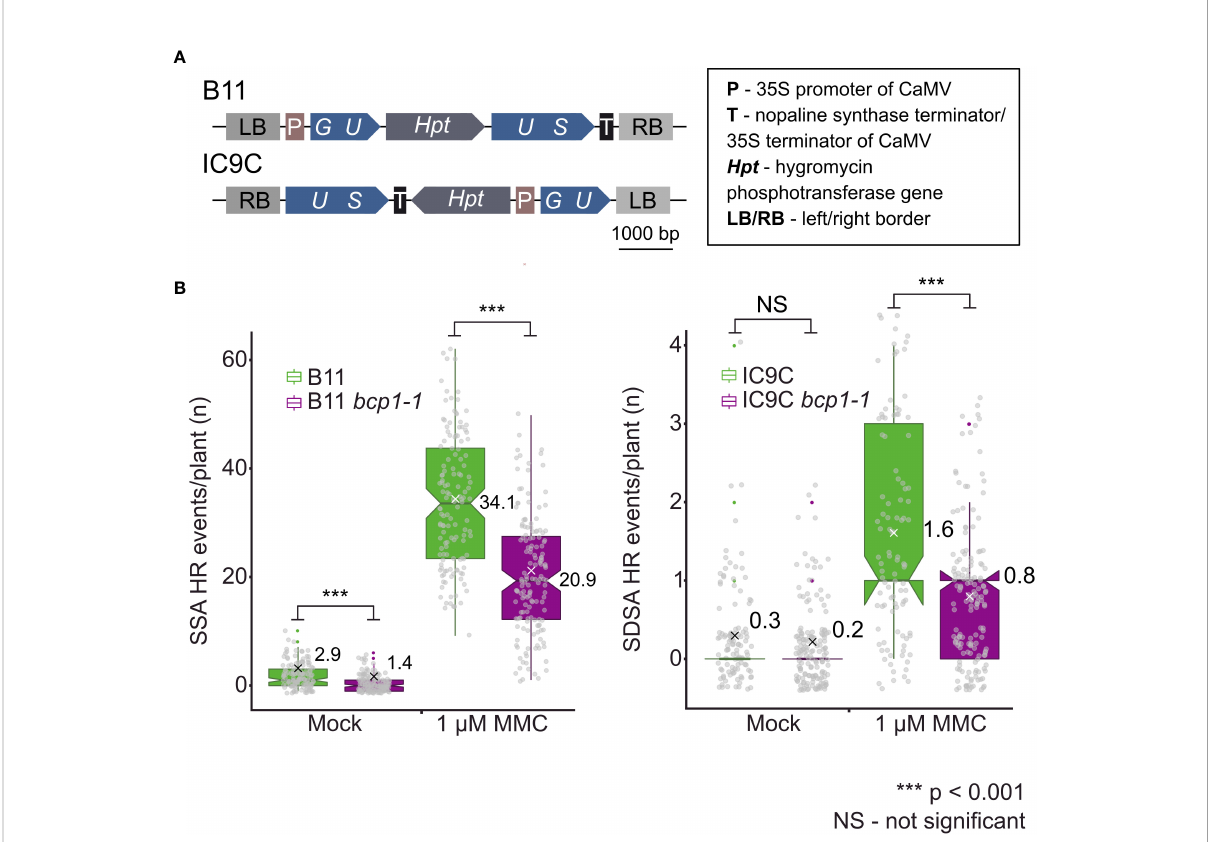
FIGURE 5 (A) Schematic model of constructs used to create B11 and IC9C HR reporter lines (Swoboda et al., 1994; Molinier et al., 2004). (B) Loss of BCP1 causes reduced frequency of somatic homologous recombination (HR). Wild type (WT) and bcp1-1 plants carrying genomic substrates for single-strand annealing ( B11 ) and synthesis-dependent strand annealing ( IC9C ) types of HR were grown on mock and 1 m M containing MMC media for 10 days. Gray dots indicate HR events per plant. The boxplots ’ hinges are in the 1 st and 3 rd quartile, with a marked median. Mean is represented by a cross with a numerical value. Whisker marks show the lowest or highest value within the 1.5 interquartile range below or above hinges. Asterisks represent signi fi cant differences in Mann-Whitney U-test *** P < 0.001, NS – not signi fi cantly